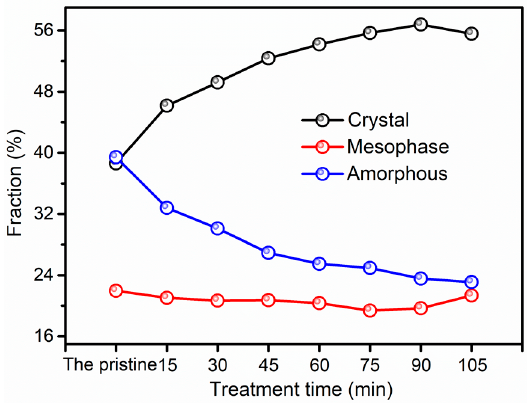
Figure 8. The crystal, mesomorphic, and amorphous fractions of the pristine and treated F-III fibers in Sc-CO 2 .